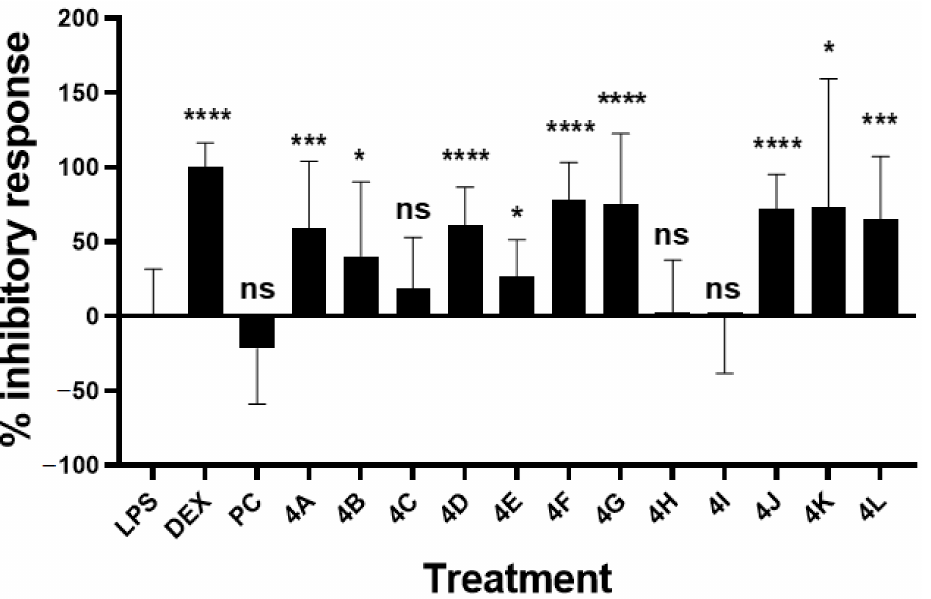
Figure 5. Inhibitory effect of analogues on LPS-induced NO production by RAW264.7. Murine macrophages RAW264.7 (150,000 cells/well in P96) were treated with LPS ( E. coli 0111:B4) at 1 µ g/mL, analogues and pinocembrin (PC) at 2 µ g/mL (in DMSO 0.1%), or anti-inflammatory dexamethasone (DEX) at 100 nM for 24 h. Nitrite representative of NO production was quantified using Griess reagent, and percent of the inhibitory response was calculated compared to the level of LPS-dependent nitrite production. Bars represent mean ± SD of 4 independent experiments (with n = 3 well replicates/experiment). Mann–Whitney test was used to compare LPS and molecule treatments. ns, nonsignificant; *, p < 0.05; ***, p < 0.0005; ****, p <